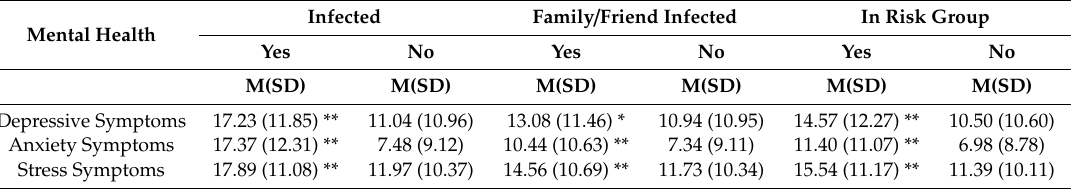
Table 1. Psychological symptoms by COVID-19